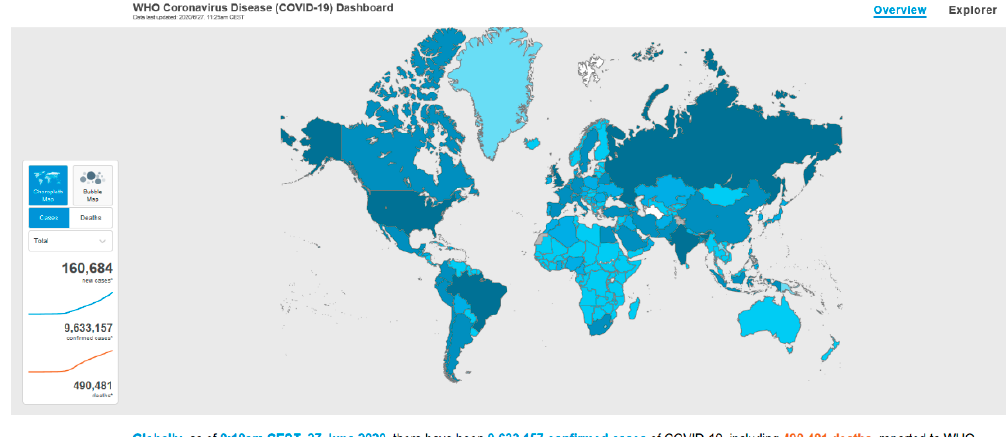
Figure 1. The World Health Organisation corona virus (COVID-19) dashboard 27 June 2020.